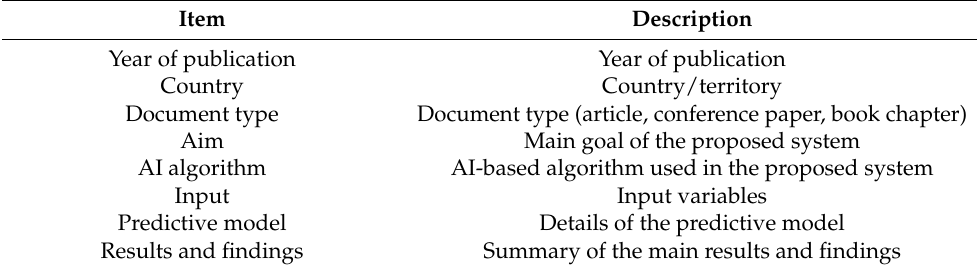
Table 3. Type of data to be extracted.